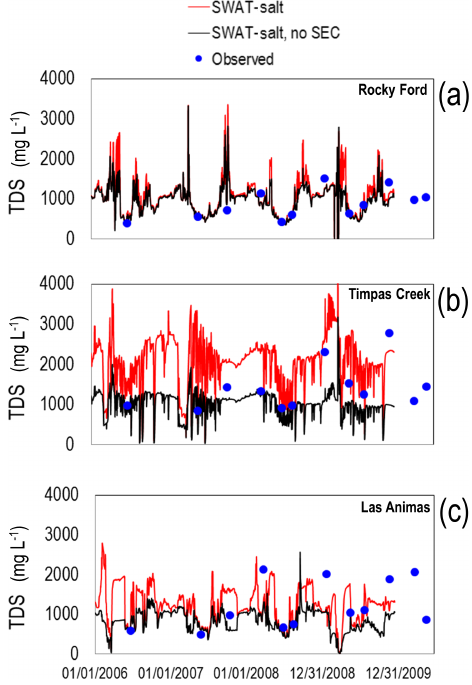
Figure 15. Simulated in-stream TDS concentration (mgL − 1 ) at the (a) Rocky Ford site, (b) Timpas Creek site, and (c) Las Animas site for the original simulation (red line) and a simulation without in- cluding equilibrium chemistry (SEC module) (black line). The mea- sured TDS values are also